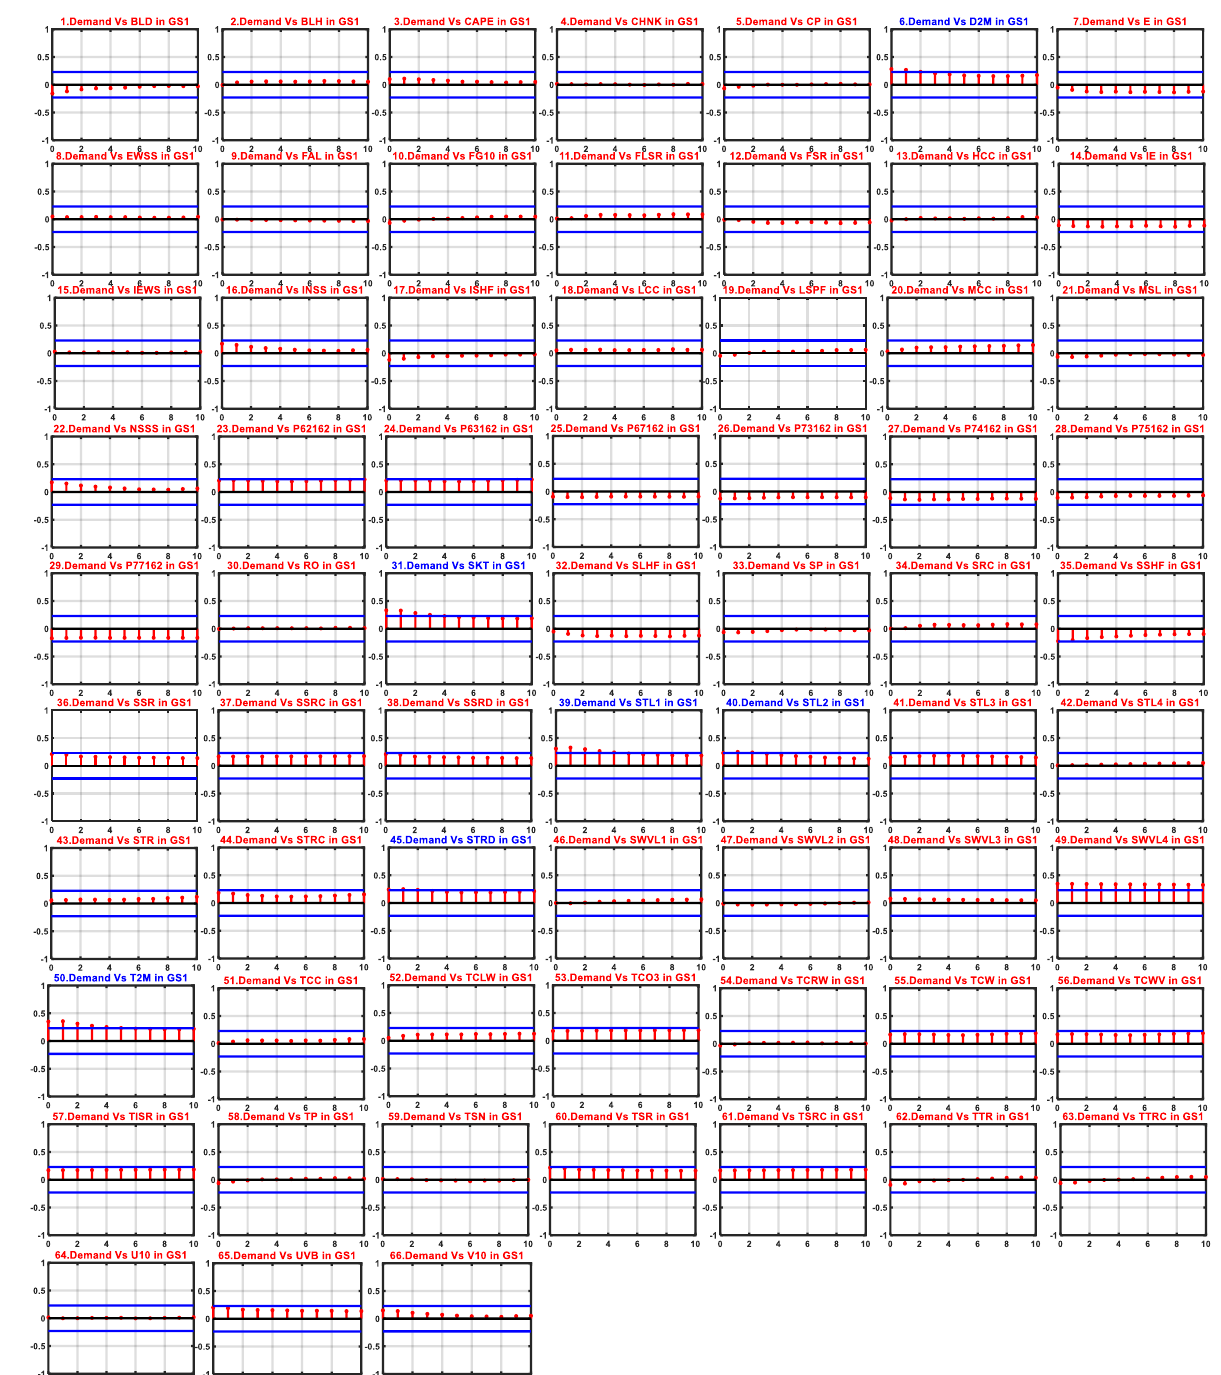
Figure A1. For the GS1 site, the outcomes of cross-correlation coefficient (daily) between electricity demand and climate variables from the ECMWF-ERA5 reanalysis dataset. The climate variables were selected based on their 95% confidence intervals and are demonstrated by the blue lines. The six chosen blue variables were based on the number of significant daily lags (from 0 to 2) and the number of decomposed power demand outputs. The details are described in Table A1.